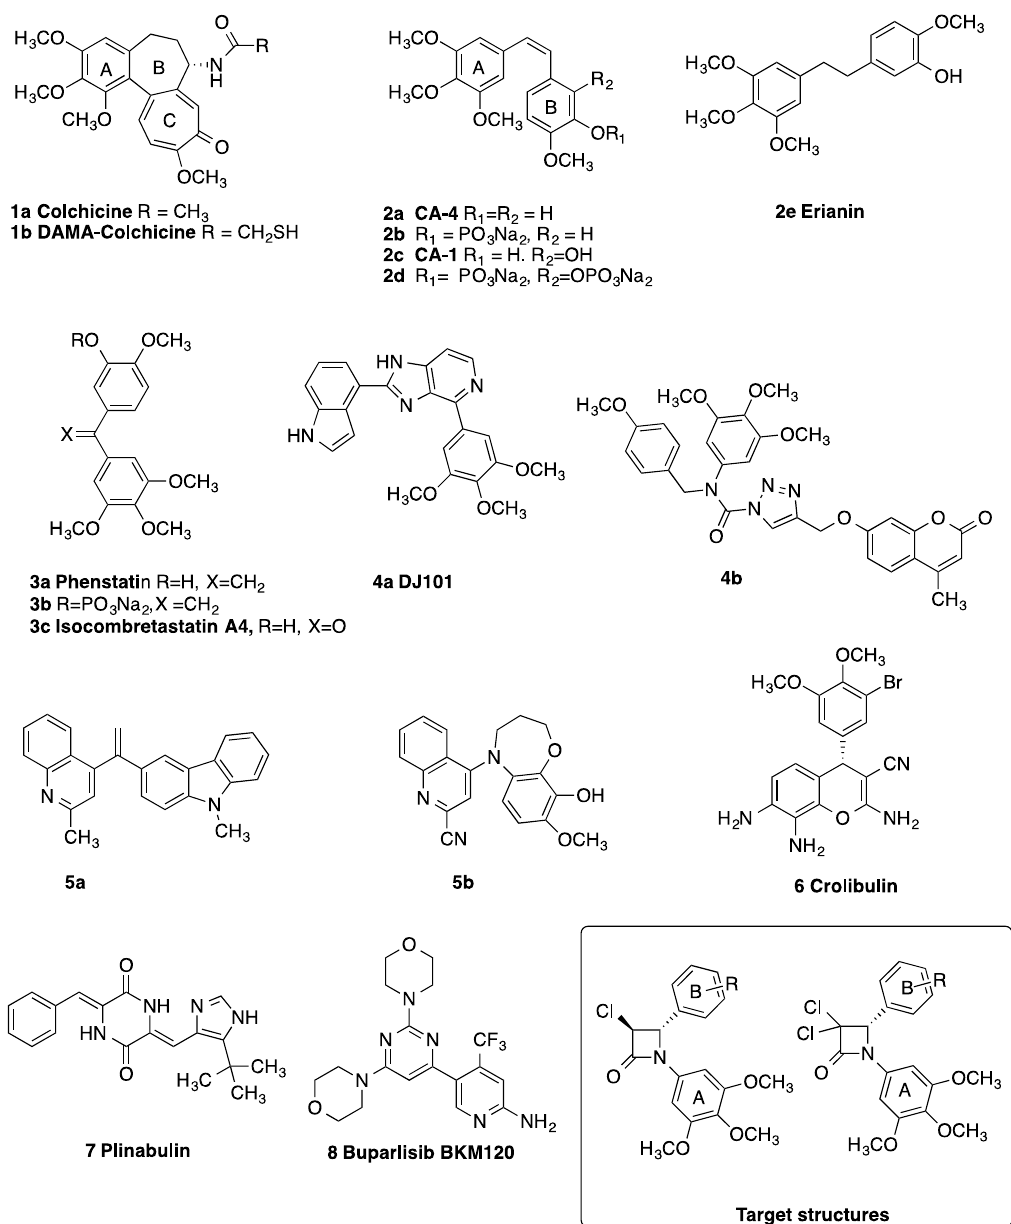
Figure 1. Colchicine ( 1a ), DAMA-Colchicine 1b , Combretastatins 2a – 2d , erianin 2e , phenstatins 3a , 3b , isocombretastatin 3c , colchicine binding site inhibitors 4a (DJ101) , 4b , quinolines 5a , 5b , Crolibulin 6 , Plinabulin 7 , Buparlisib BKM120 8 and target β -lactam structures.